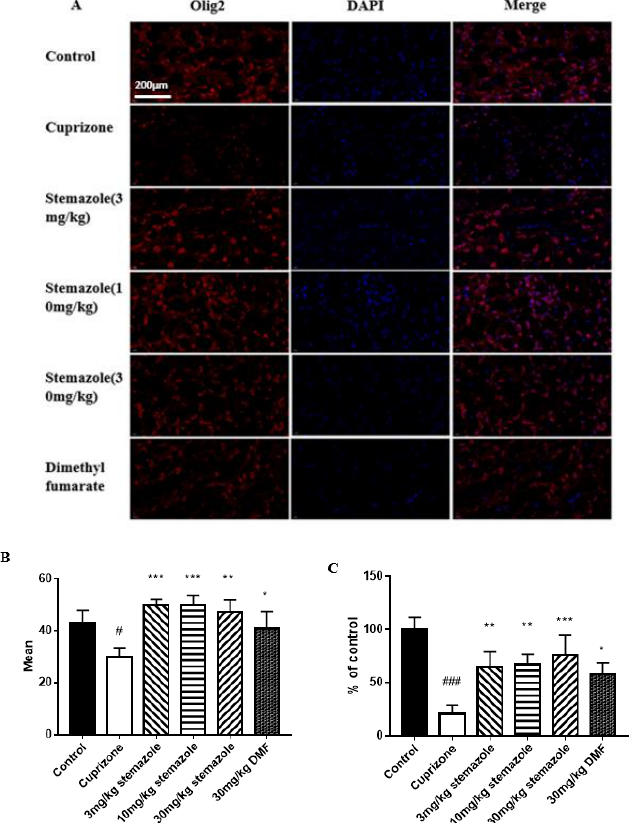
Figure 7. The promoting effect of stemazole on the expression of the OL-specific transcription factor Olig2 by immunofluorescence. ( A ) Olig2 immunofluorescence to assess Olig2 expression. ( B ) The average fluorescence intensity of Olig2 expression. ( C ) The olig2 cells/mm 2 were compared with that of the control and expressed as a percentage of the control value using ImageJ software. Data represent the means ± SD ( n = 3 duplicates). * p < 0.05, ** p < 0.01 *** p < 0.001 vs. the CPZ group. # p < 0.05, ### p < 0.001 vs. control group. Taken together, stemazole recovered the learning ability and movement coordination ability of demyelination animals. In addition, stemazole increased the expression of OLs and promoted remyelination by histology. Moreover, stemazole performed significantly better than positive control drugs in promoting the recovery of myelin.